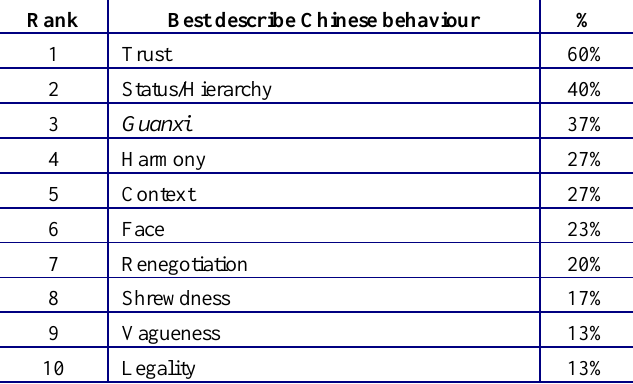
Table 2: Ranking summary